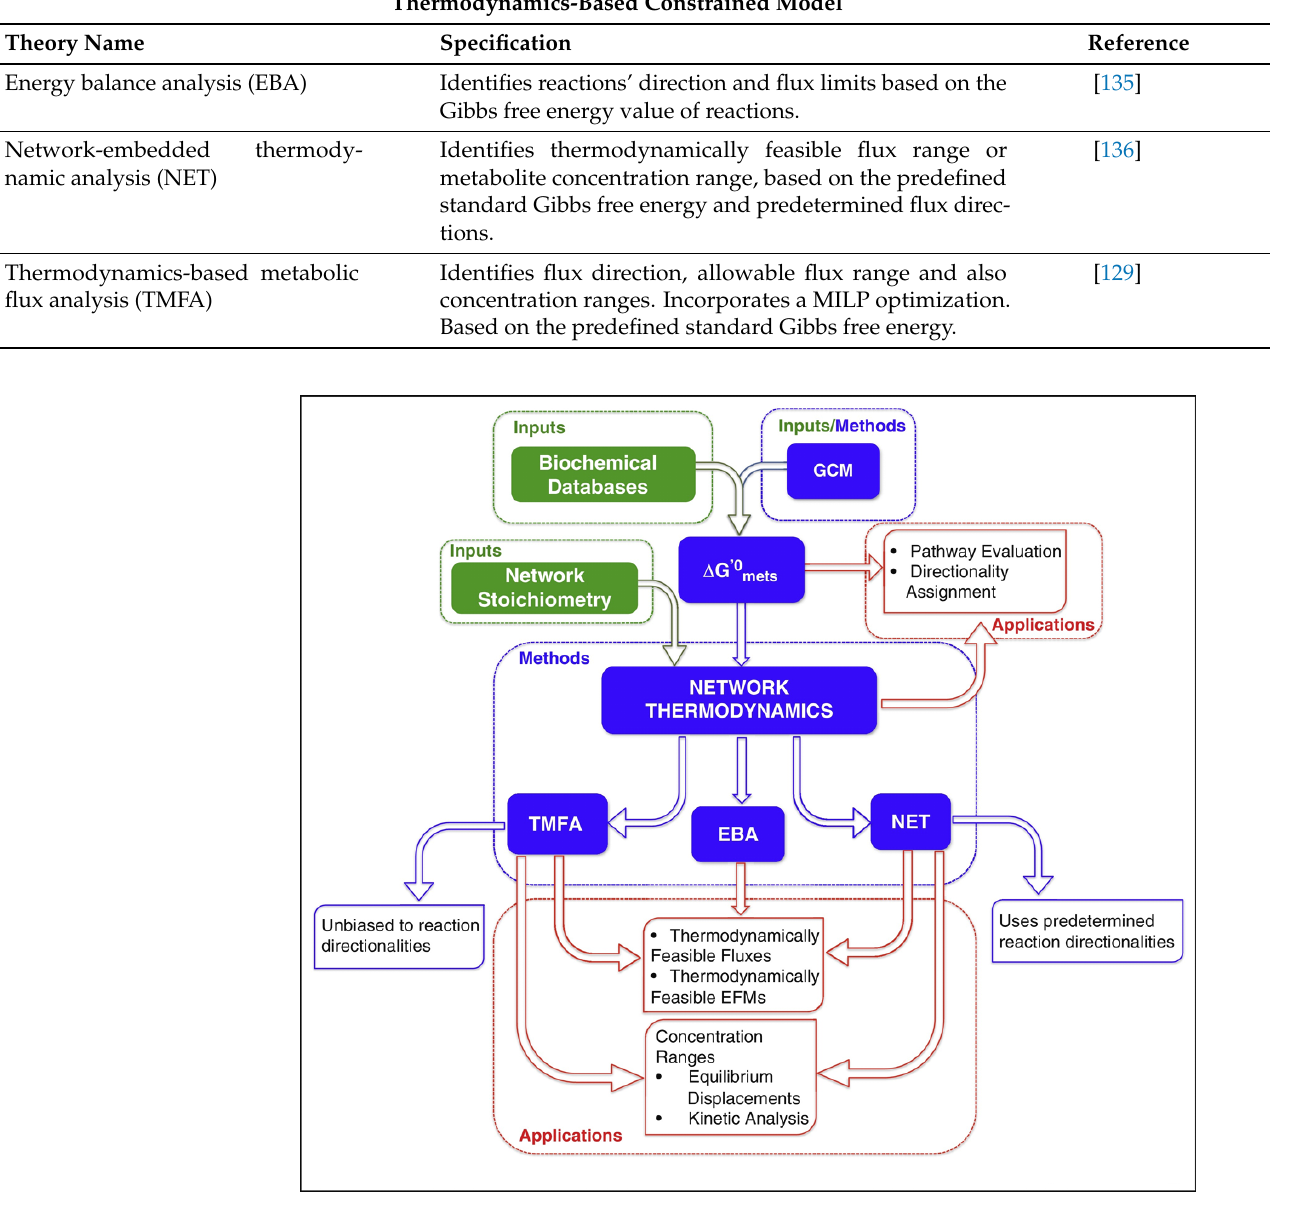
Figure 5. Thermodynamics-based modelling of metabolic networks. Thermodynamics integration to metabolic networks modelling allows computation of fluxes and EFMs that are thermodynamically feasible. The feasible concentration ranges of metabolites can be estimated and then used for estimating the distance from the equilibrium. Reused with permission from